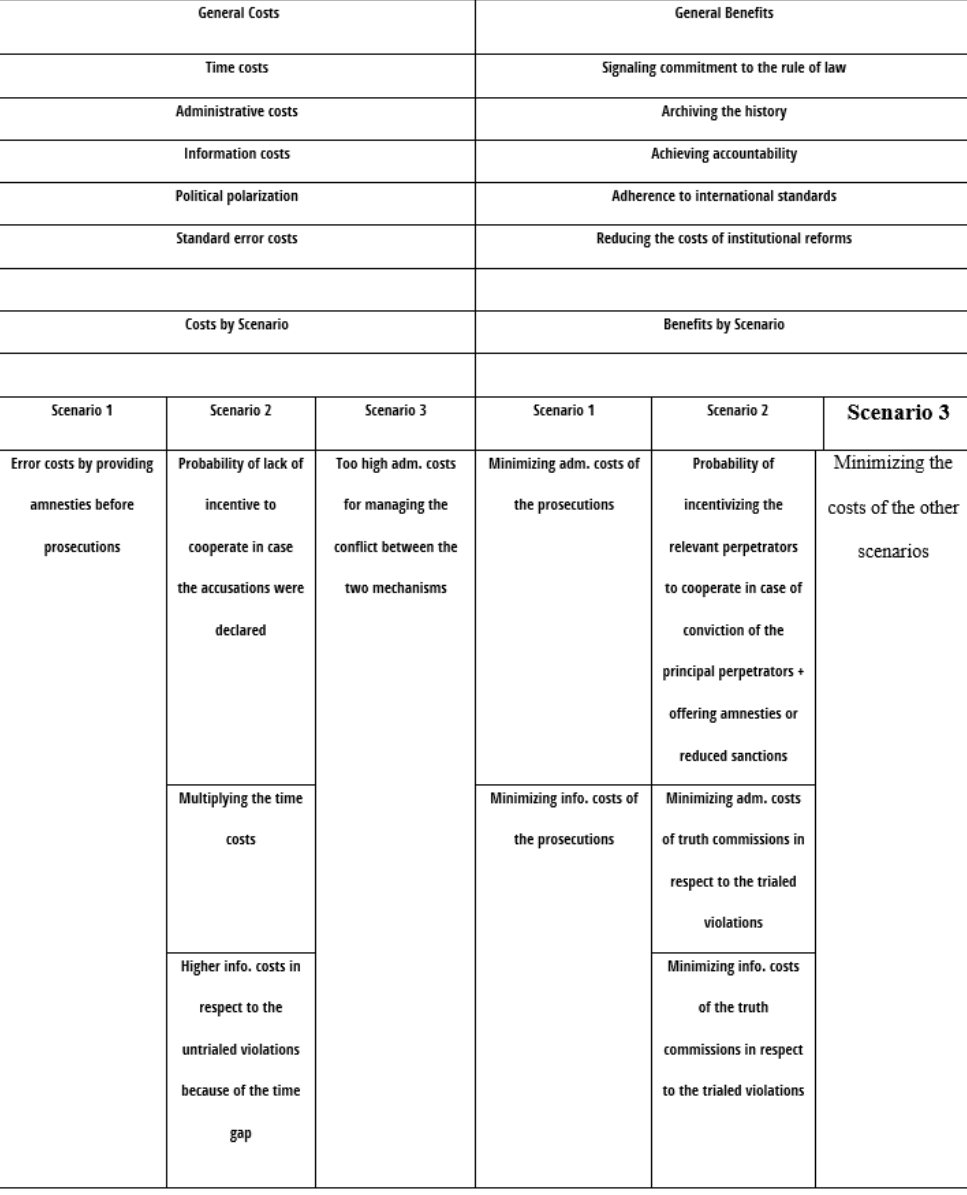
Figure 2: Table (2) Cost-Benefit Matrix of Truth Commissions as a T.J.